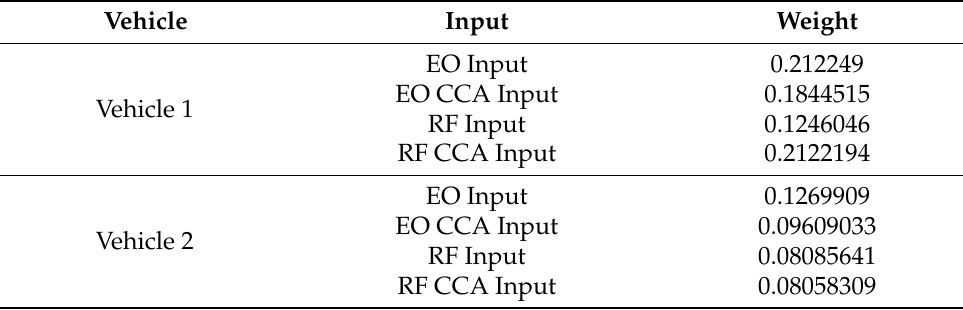
Table 2. explainX.ai weight results for Scenario